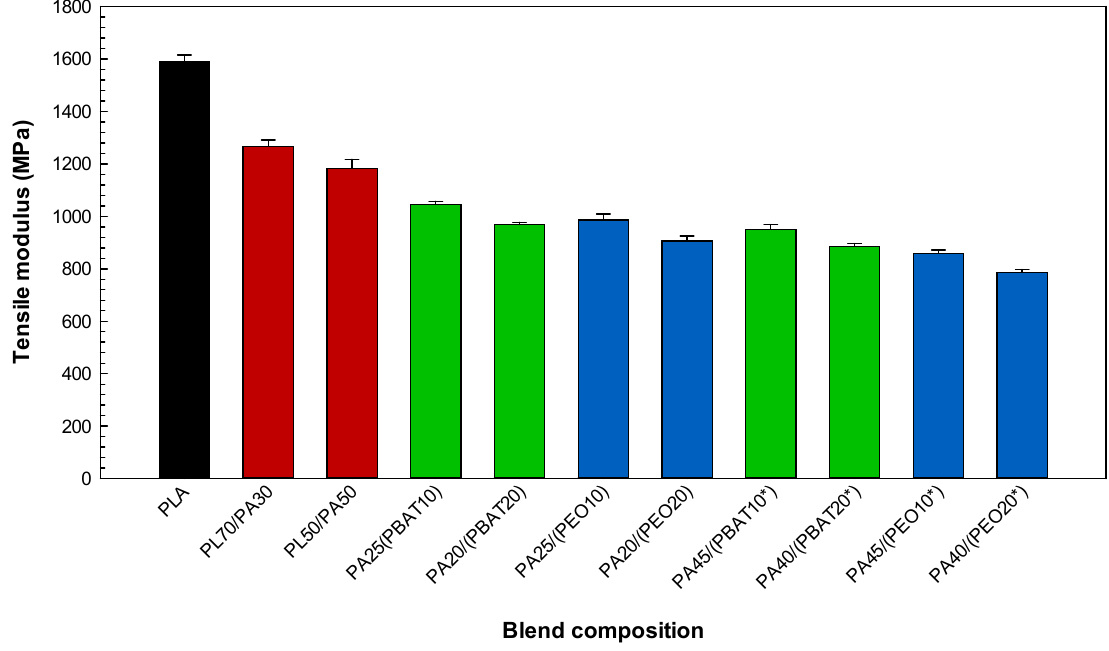
Figure 7. Tensile modulus of the blends (see Section 3.2 for definition).